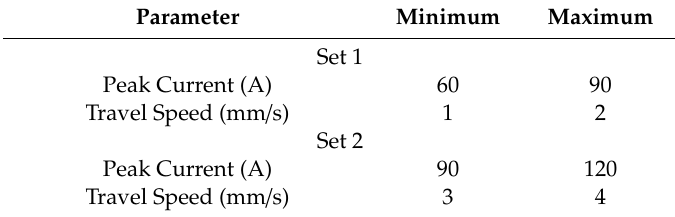
Table 3. Split parameter set used for designing the experiment.